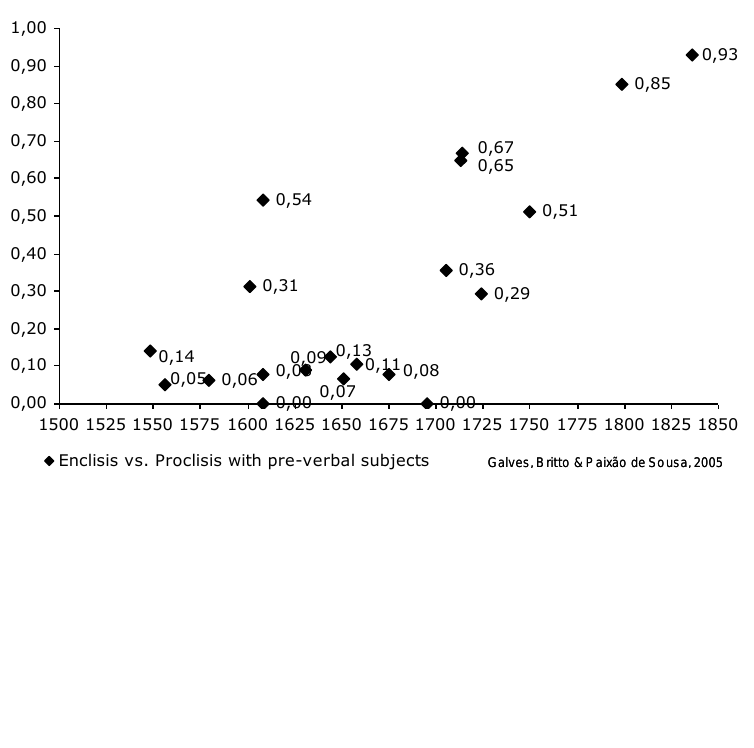
Figure 2a : Enclisis versus Proclisis with pre-verbal subjects